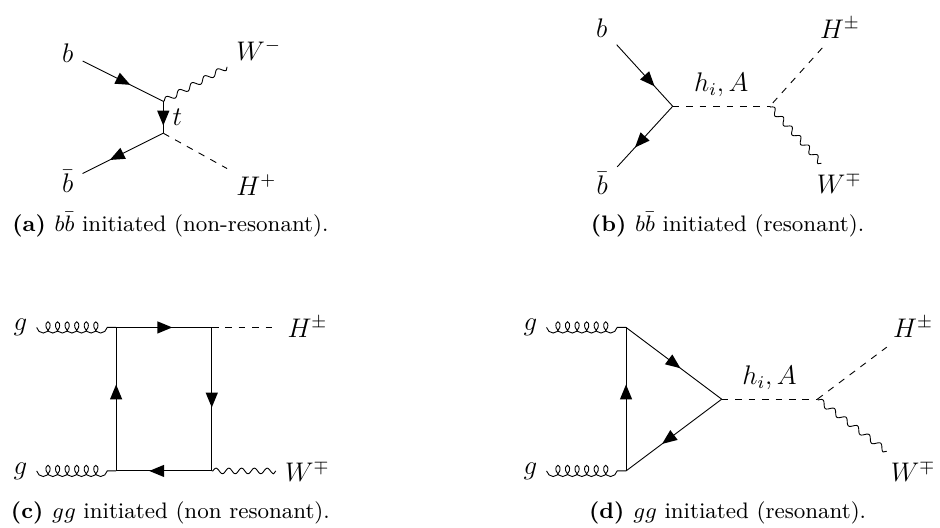
Figure 9. Leading-order Feynman diagrams for pp → H ± W ∓